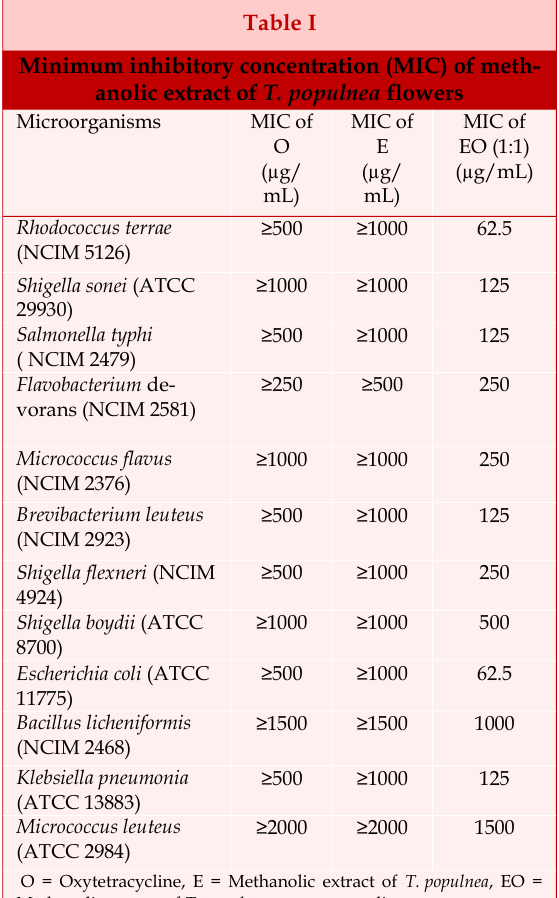
Minimum inhibitory concentration (MIC) of meth- anolic extract of T. populnea